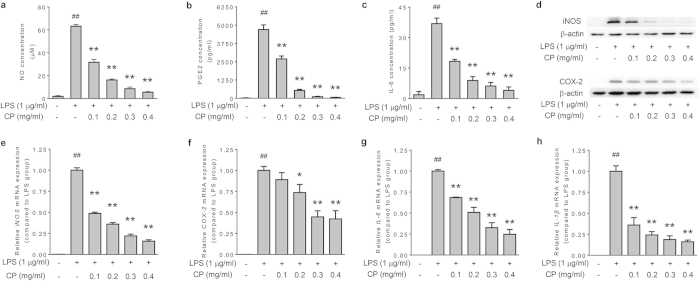
Anti-inflammatory effects of Cardiotonic Pill in LPS-stimulated RAW264.7 macrophages.Cells were pretreated with different concentrations of CP (0.1–0.4 mg/ml) for 1 h, followed by treatment with LPS (1 μg/ml) and incubation for indicated time. Concentration of (a) NO, (b) PGE2 and (c) IL-6 in the supernatant. (d) Protein expression levels of iNOS and COX-2. β-actin was used as an internal loading control. The expression levels of mRNA for (e) iNOS, (f) COX-2, (g) IL-6 and (h) IL-1β were analyzed by quantitative real-time PCR. GAPDH served as internal control for normalization of mRNA expression. Data are presented as mean ± SD of three independent experiments performed in duplicate. ##p < 0.01 versus control group; *p < 0.05, **p < 0.01 versus LPS group (one-way ANOVA, Dunnett test). CP: Cardiotonic Pill.